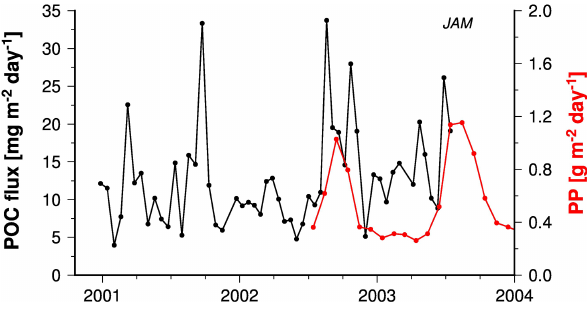
Figure 6. Organic carbon fluxes measured at JAM and the primary production rates selected for the JAM